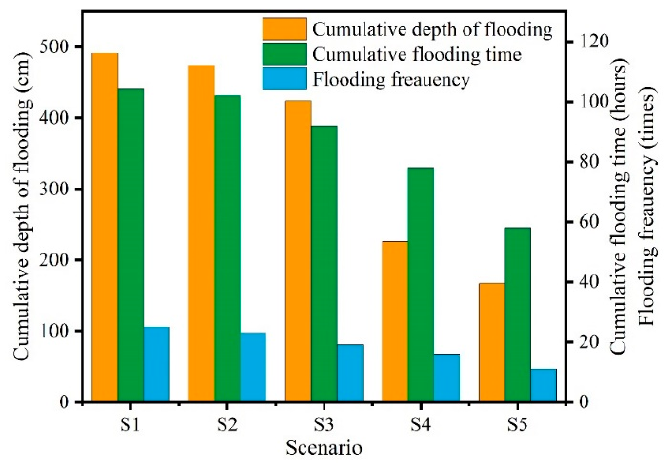
Figure 6. Cumulative flooding time, flooding frequency, and cumulative flooding depth of each scenario.